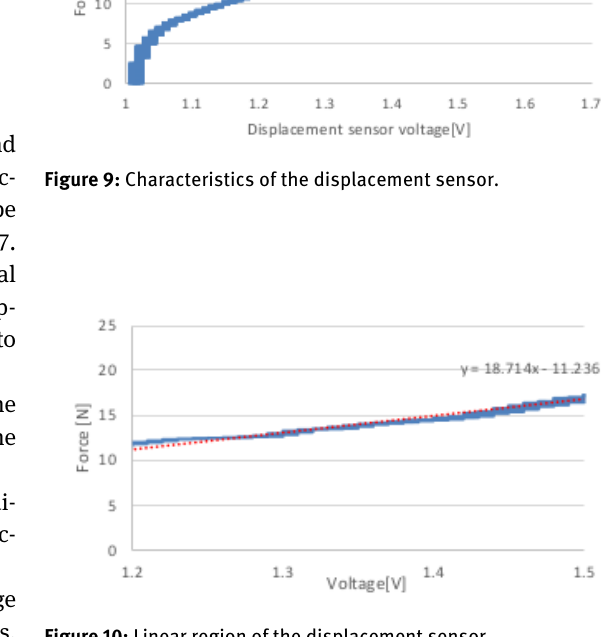
Figure 10: Linear region of the displacement